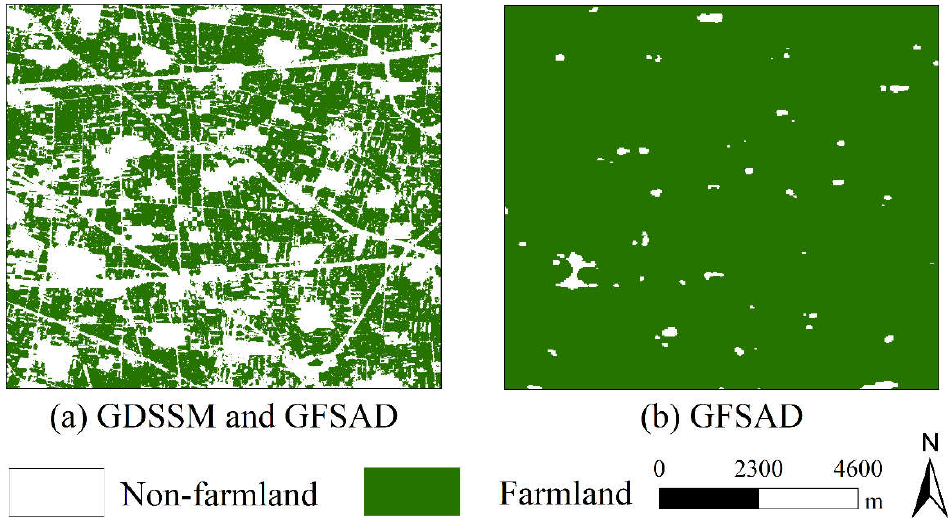
Figure 7. Analysis of the farmland mask for ( a ) GDSSM and GFSAD and ( b ) GFSAD.